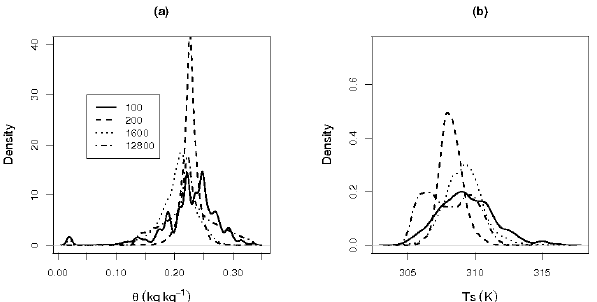
Fig. 4. Spatial probability density functions of (a) soil moisture ( θ , [kgkg − 1 ]) and (b) the surface temperature ( T s , [K]) for light wind speed scenario at the final time step for different levels of decom- position.